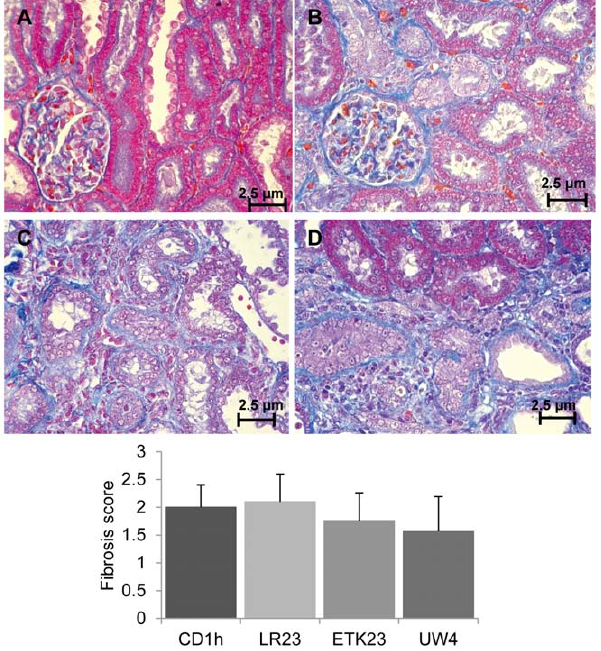
Figure 4. Pathological status of kidney graft after kidney transplantation (RTx). After euthanasia on day 14 after RTx, kidneys were harvested and stained with azan stain for parenchymal fibrosis. Fibrosis was graded numerically as follows; (A): 0= none, (B): 1=minimal, (C): 2=moderate, and (D): 3=severe. In each slide, 20 fields were evaluated by four observers blinded to treatment (4 6 20 fields). Fibrosis of the group receiving kidneys preserved with ETK23 tended to be lower than that of the other groups, but the difference was not significant ( p . 0.05).